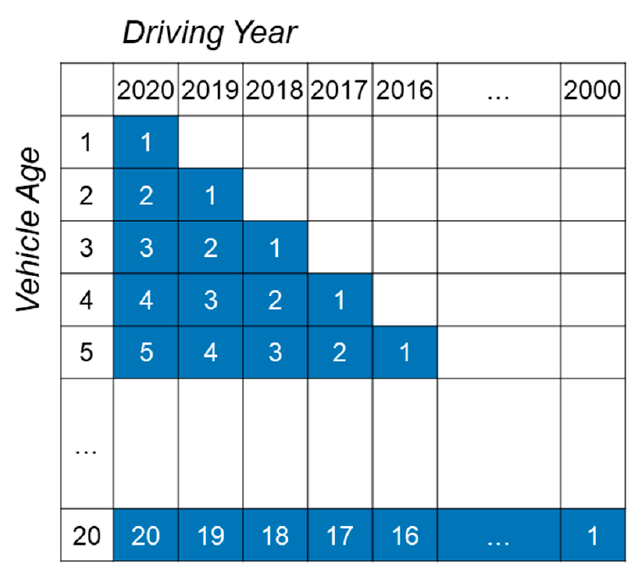
Figure 1. Schematic diagram of odometer record meaning (in 2020).